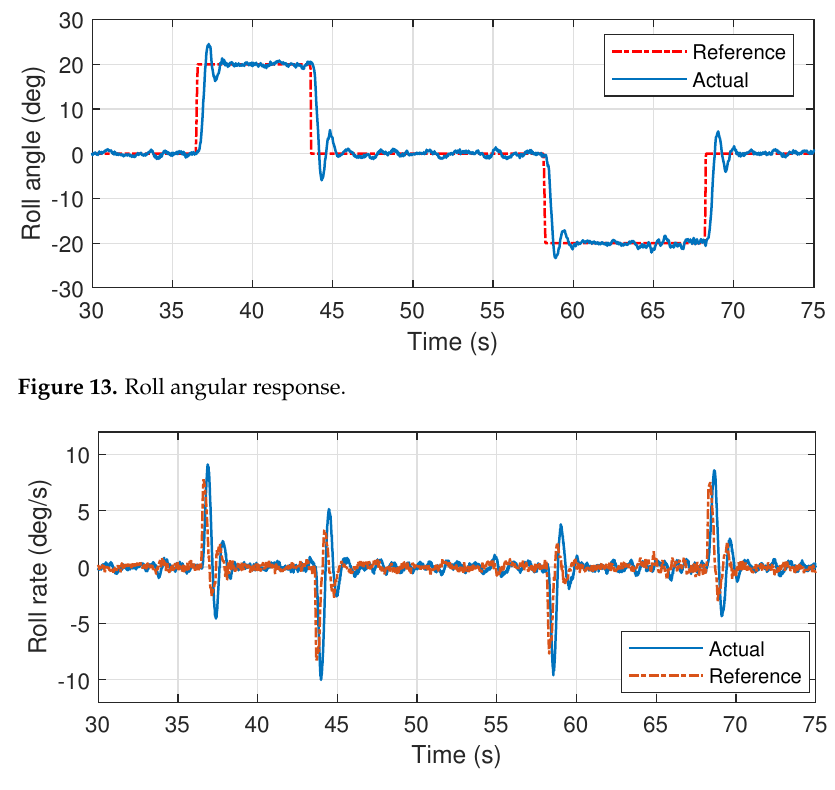
Figure 14. Roll angular rate